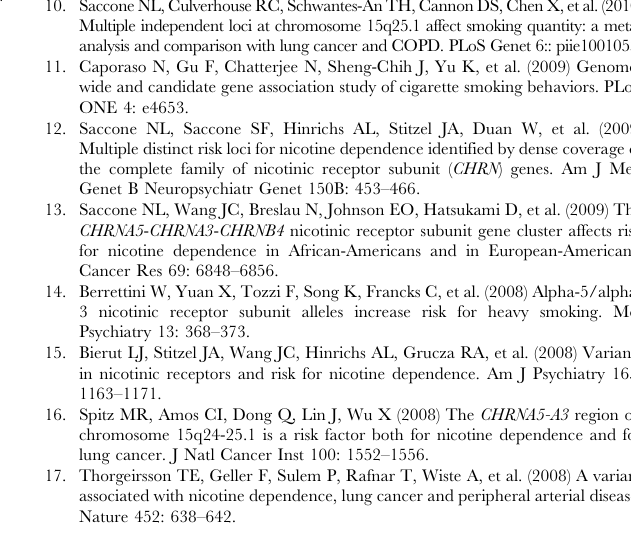
Figure S2 Allelic expression imbalance (AEI) of CHRNA3 and CHRNA5 in post-mortem brain regions. The SNaPshot system was used to assess the relative allelic expression of either CHRNA3 (A) or CHRNA5 (B) in complemen- tary DNA (cDNA) preparations derived from mRNA of post- mortem brain regions, including the prefrontal cortex (PFC, black symbols), amygdala (Amyg, blue symbols) or nucleus accumbens (Nacc, red symbols). Allelic expression was quantified for each sample using the formula: f ( a ) ~ Ha = ( Ha z kHb ) where f (a) is the relative frequency of the ‘a’ allele expression, H a and H b are the peak heights of alleles ‘a’ and ‘b’ in cDNA and k corrects for the unequal amplification of SNP alleles in a heterozygous gDNA sample and is equal to ‘a/b’ where ‘a’ and ‘b’ are the peak heights of the two alleles in gDNA [28]. The averages 6 standard deviations of at least two determinations for each point are shown. The dashed lines at 40% and 60% represent the boundaries of what are considered AEI-positive determinations ( i.e. differences of greater than 20%) using this method of calculation [28]. (A) The shown for all heterozygous individuals tested in the PFC (black symbols; individuals 1 through 6 are represented as a closed square, open square, closed triangle, open triangle, closed circle or open circle, respectively), the Amyg (blue symbols; individuals 7 through 12 are represented as a closed square, open square, closed triangle, open triangle, closed circle or open circle, respectively) or the Nacc (red symbols; individuals 7 through 12 are represented as a closed square, open square, closed triangle, open triangle, closed